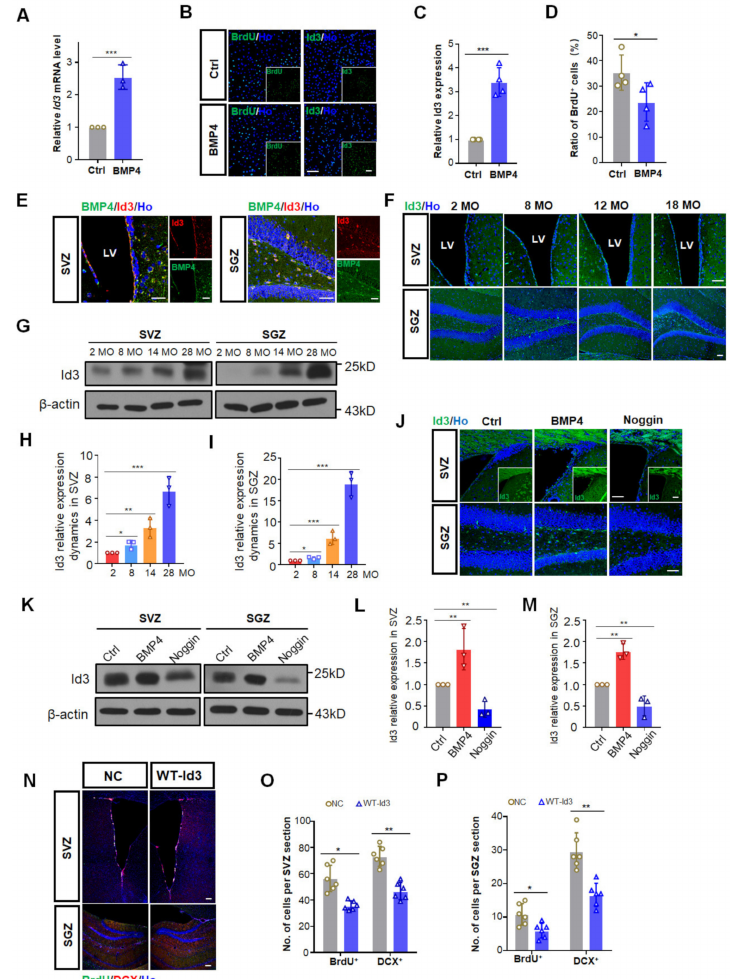
Figure 3. Id3 acted as an effector of canonical BMP signal during aging. ( A ) Transcription level of Id3 in ctrl and BMP4 treated C17.2 mouse stem cells analyzed by qPCR. n = 3. *** p < 0.001. ( B ) Representative images of Id3 and BrdU immunostaining in ctrl and BMP4 treated C17.2 mouse stem cells. Scale bar, 100 µ m. ( C ) Calculation of Id3 expression in ctrl and BMP4 treated C17.2 mouse stem cells. *** p < 0.001. ( D ) Calculation of BrdU positive cells in ctrl and BMP4 treated C17.2 mouse stem cells. * p < 0.05. ( E ) Representative images of Id3 and BMP4 colocalization in the SVZ and SGZ and SGZ of female mice at 2, 8, 12 and 18 MO. Scale bar, 50 µ m. ( G ) Western blotting analyses